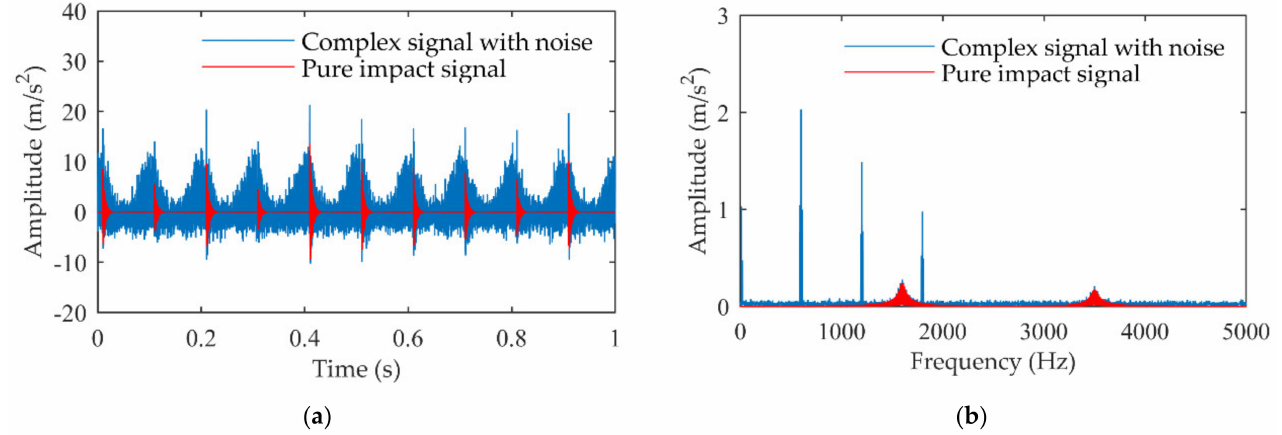
Figure 2. Thegearlocalfaultsimulationsignalwithnoise: ( a )Timedomainsignaland( b )amplitudespectrum.